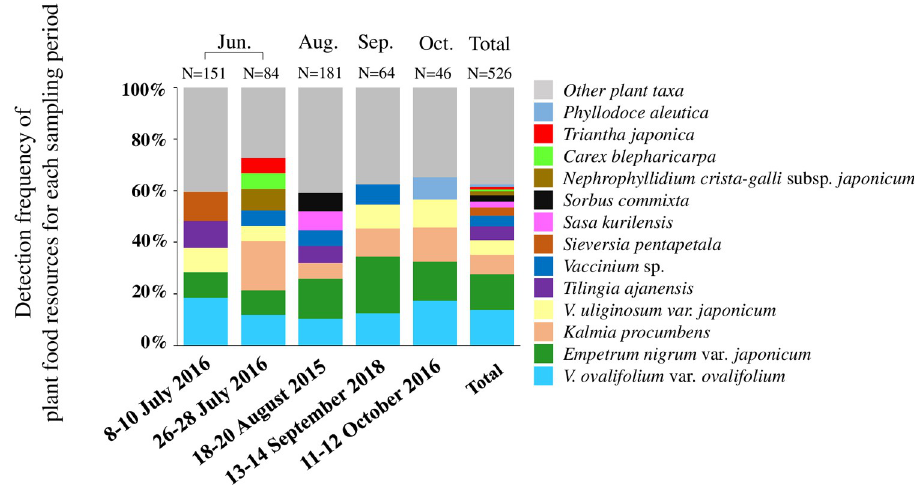
Fig 3. Intra-annual changes in major food plant taxa. The dominant plant species in each of the five fecal sampling periods are shown. N indicates the total number of food plant taxa for each fecal sampling period.